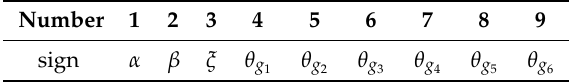
Table 1. Introducing determined dimensions in Figure 4.